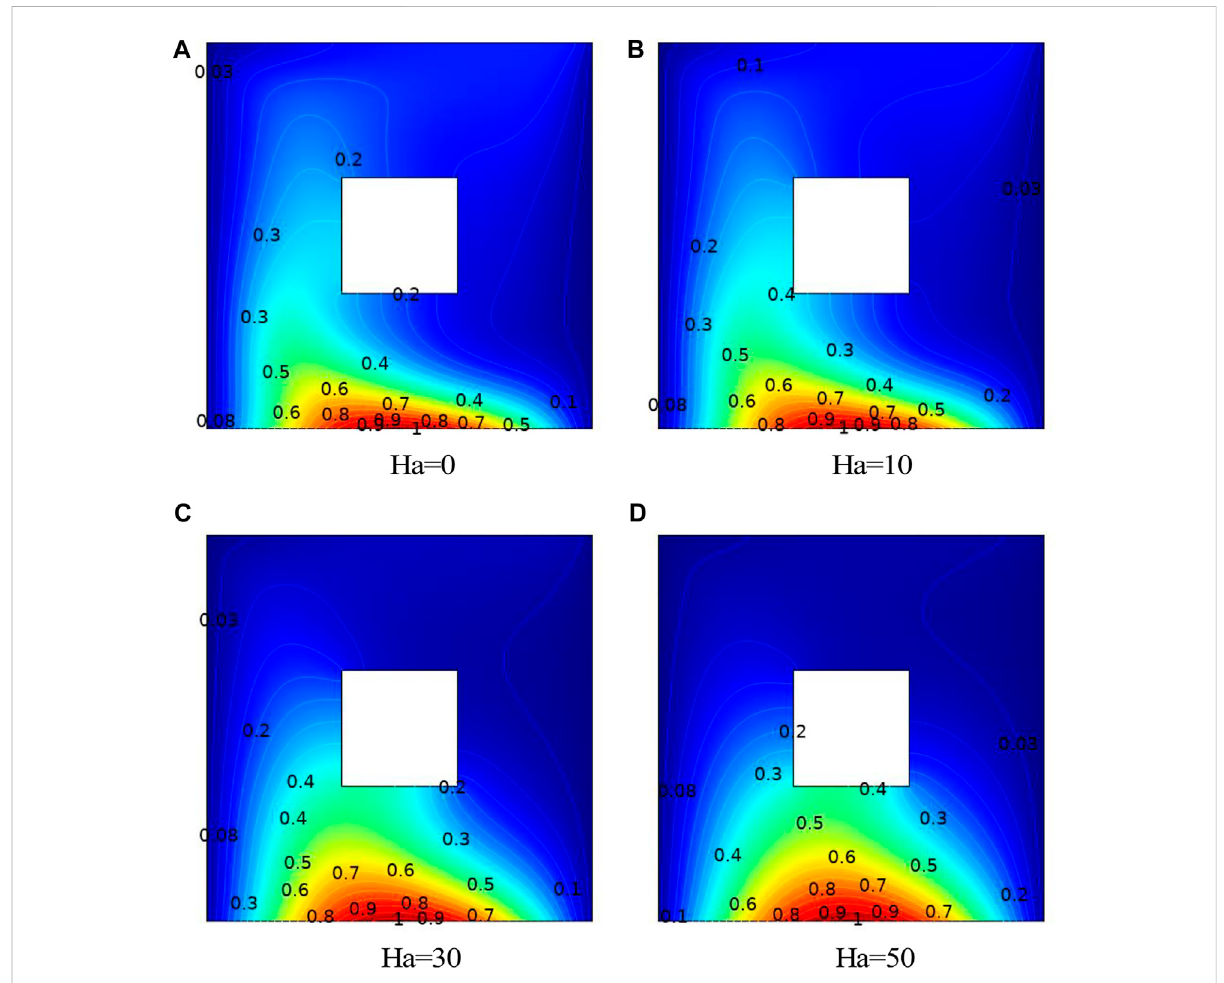
FIGURE 14 In fl uence of Ha on isotherms with a non-uniformly heated bottom wall: adiabatic cylinder with Re (cid:2) 100 and Gr (cid:2) 10 4 .